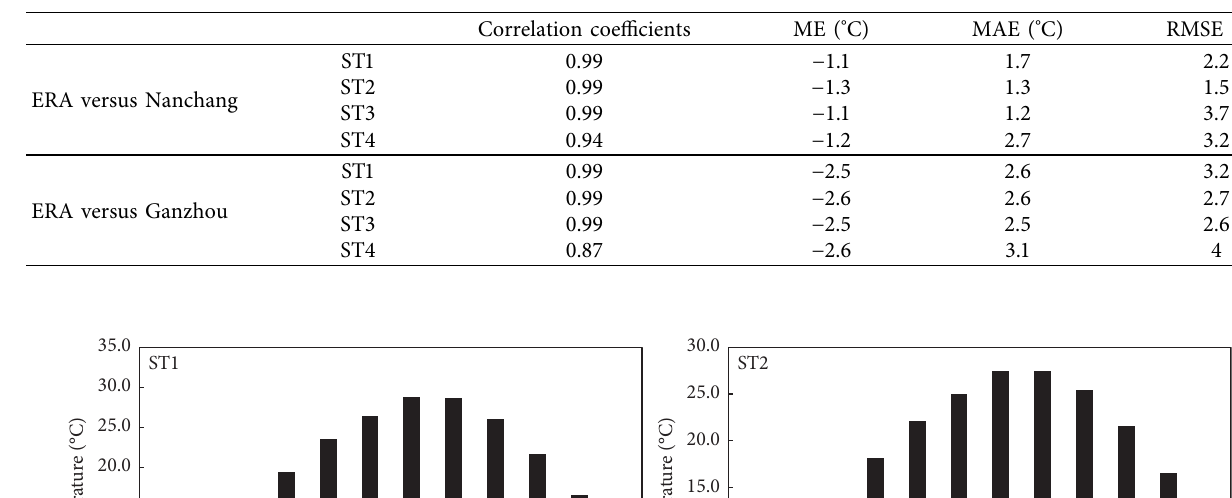
Table 1: The monthly variations of ERA and obs. soil temperature